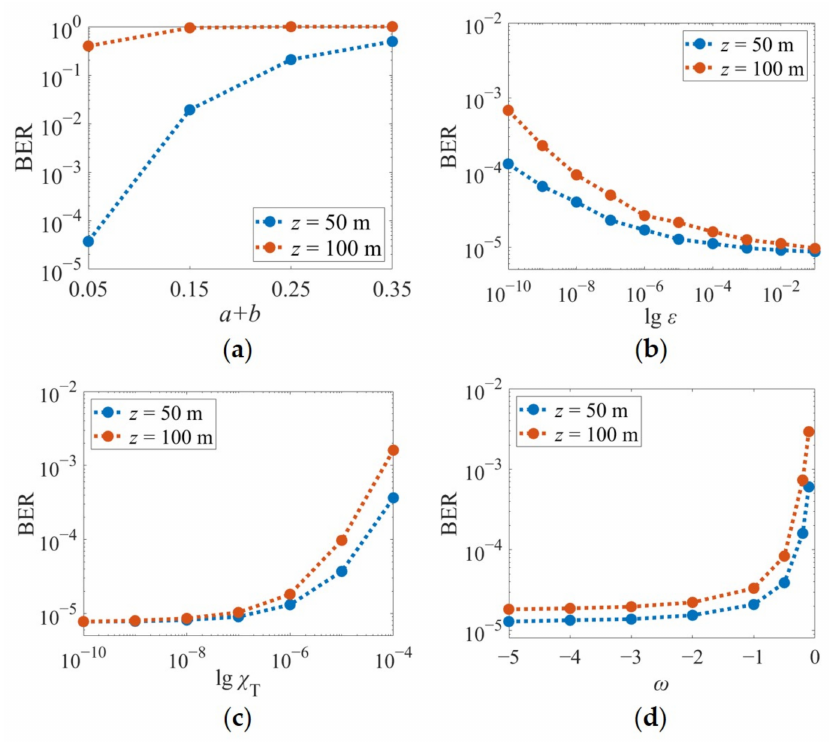
Figure 12. BER versus ( a ) a + b , ( b ) lg ε , ( c ) lg χ T , and ( d ) ω with different transmission distances.